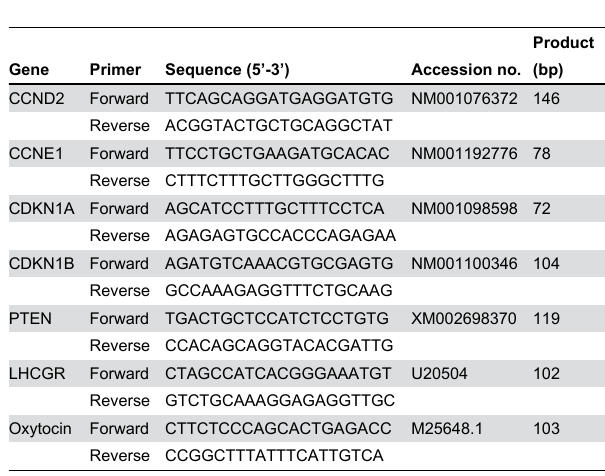
Table 1. Primers used in quantitative RT-PCR.